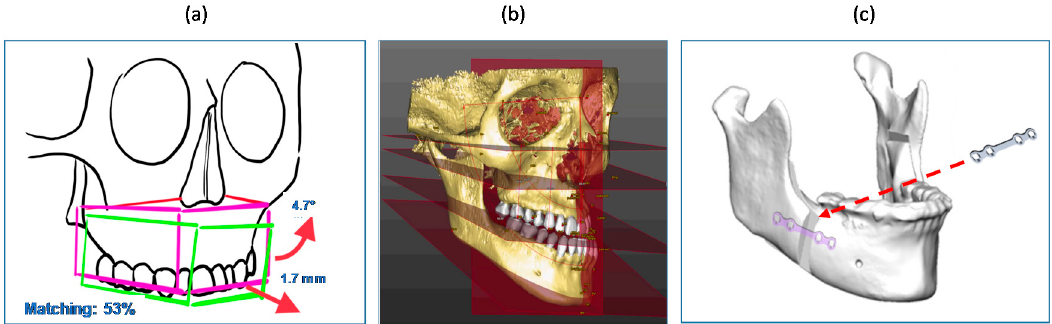
Figure 9. Examples of future virtual content to be displayed by VOSTARS: ( a ) numeric and arrow indicators for guiding bone repositioning; ( b ) cephalometric data and planes; ( c ) osteosynthesis devices.